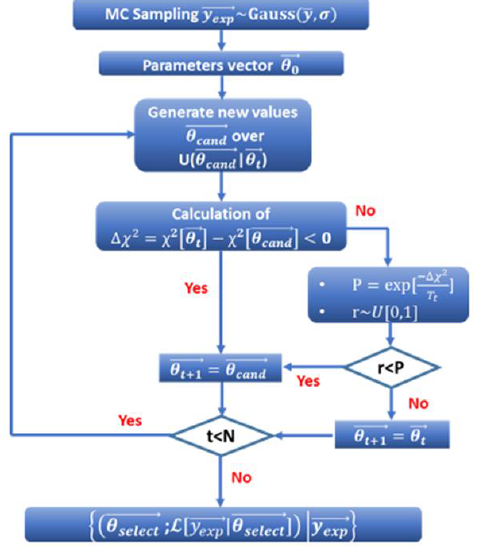
Fig. 3. Schematic diagram of the Bayesian Inference with the Bootstrap method and Simulated Annealing algorithm. The 𝑦 𝑒𝑥𝑝 ⃗⃗⃗⃗⃗⃗⃗⃗⃗ represents the sample of experimental data, 𝜃 𝑐𝑎𝑛𝑑 ⃗⃗⃗⃗⃗⃗⃗⃗⃗⃗⃗⃗ represents the candidate parameter vector sampling according to a uniform distribution 𝑈(𝜃 𝑐𝑎𝑛𝑑 ⃗⃗⃗⃗⃗⃗⃗⃗⃗⃗⃗⃗|𝜃 𝑡 ⃗⃗⃗⃗) , 𝜃 𝑠𝑒𝑙𝑒𝑐𝑡 ⃗⃗⃗⃗⃗⃗⃗⃗⃗⃗⃗⃗⃗ the selected parameter vector and N is the number of iterations.